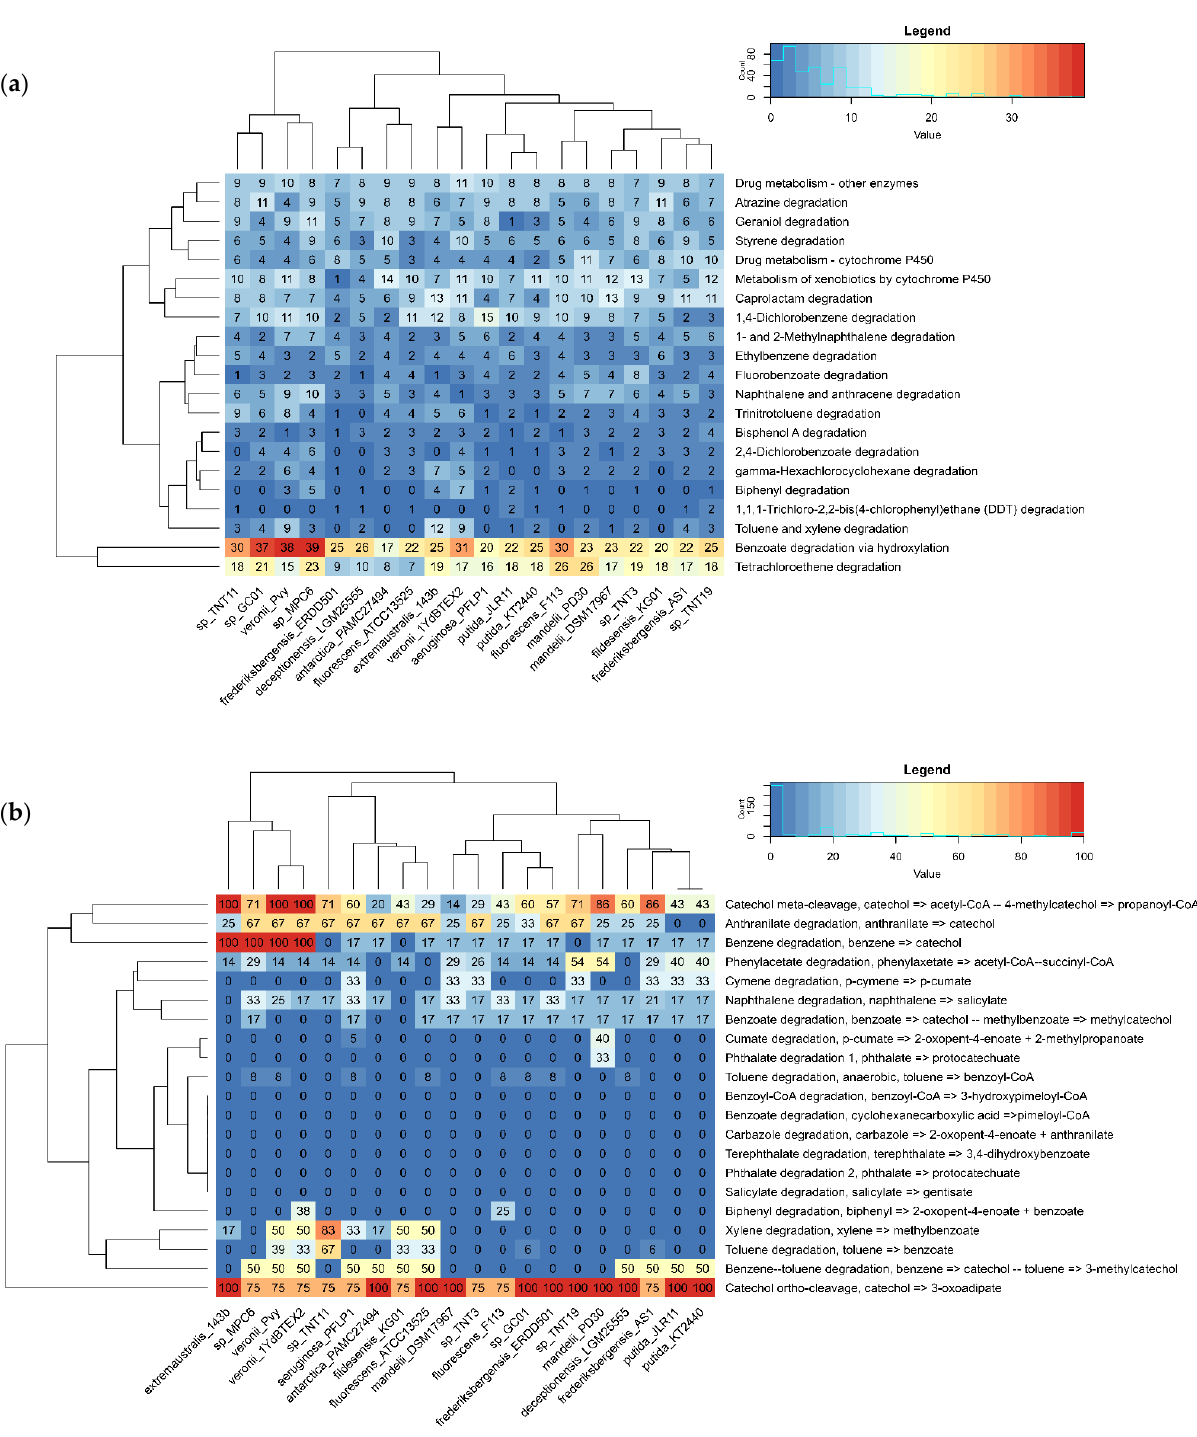
Figure 1. Xenobiotics and aromatics degradation potential of pseudomonads analyzed in this study. ( a ) Count of genes in “xenobiotics degradation and metabolism” pathway according to PATRIC/RASTtk annotation; ( b ) percentage of completeness of “aromatics degradation” KEGG modules obtained with MicrobeAnnotator for TNT isolates and all non-pathogenic pseudomonads included in the analysis.